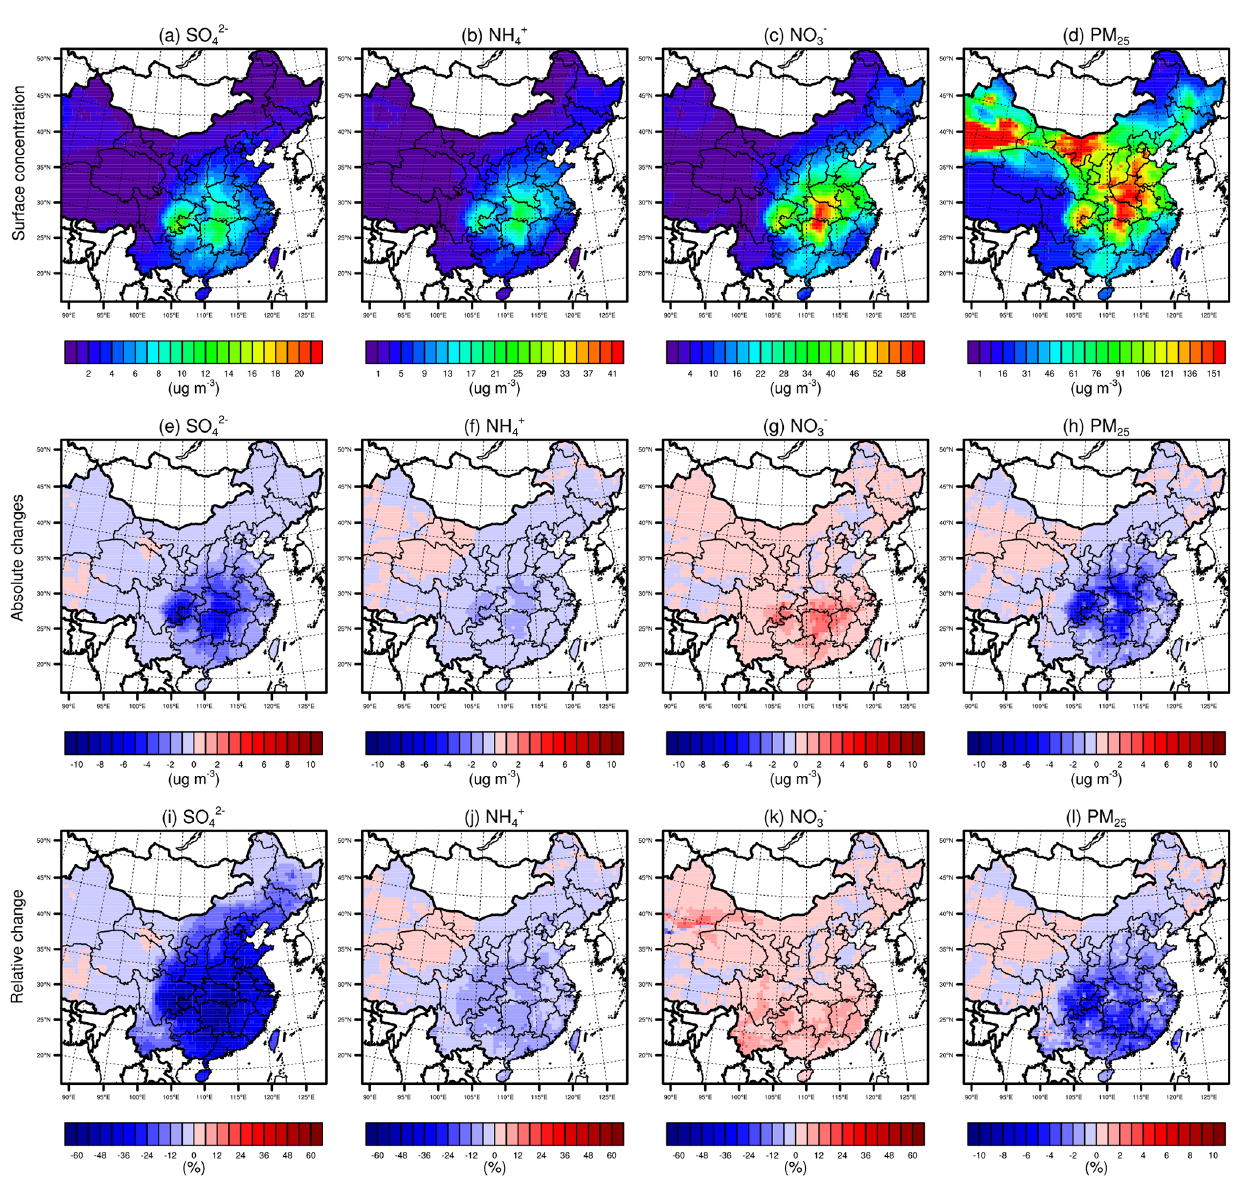
Figure 12. Spatial distributions of the averaged surface concentrations of the sulfate, ammonium, nitrate, and PM 2 . 5 over 11 November to 1 December 2016, simulated with the CBMZ/MOSAIC mechanism and the MIX emissions in November 2010, and the absolute and relative changes of the associated aerosol surface concentrations with the updated emissions by data